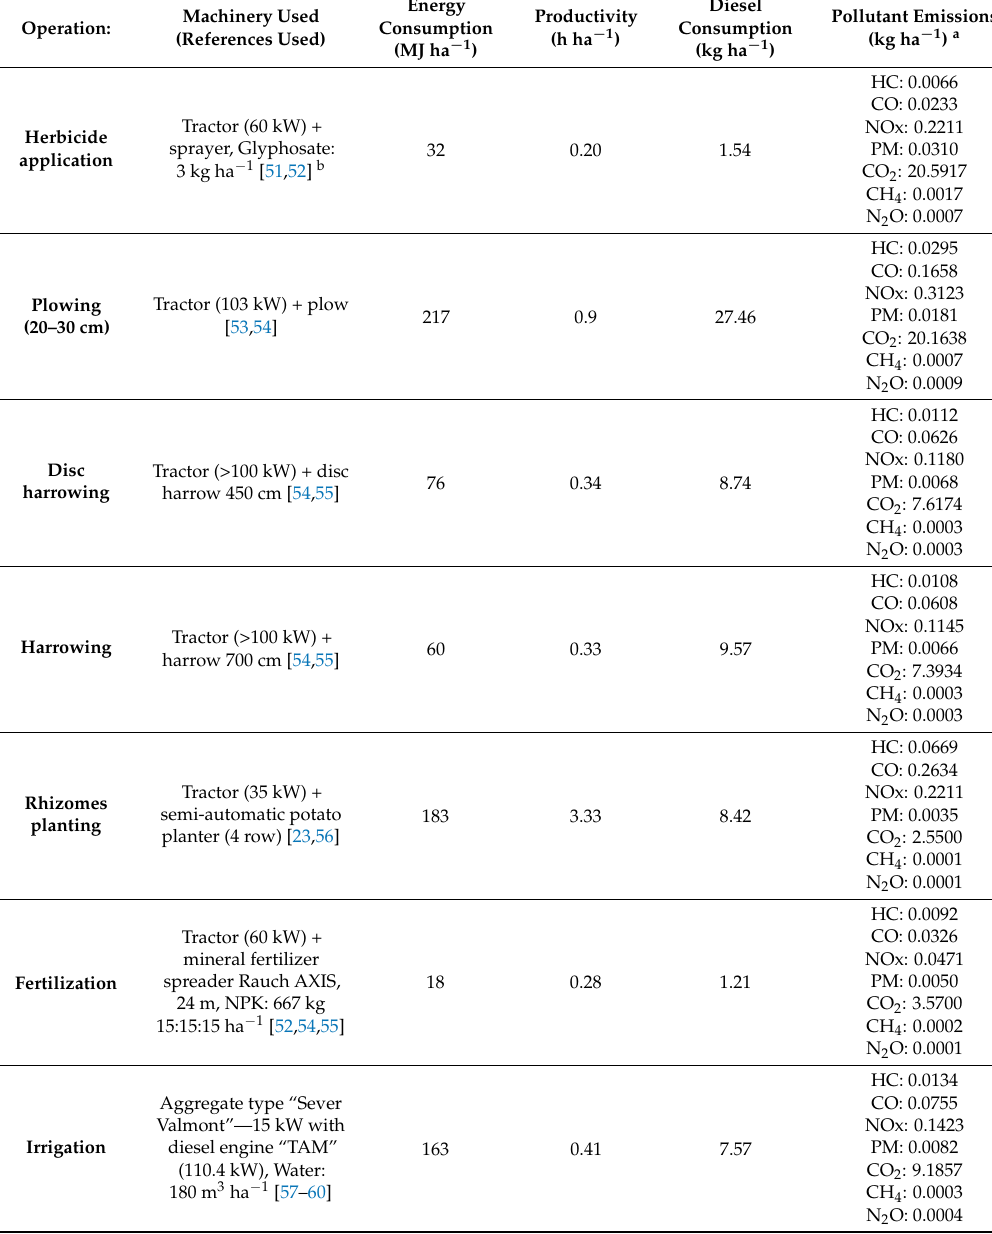
Table 1. Miscanthus ( Miscanthus × giganteus Greef et Deu.) life cycle operations, machinery selection, productivity and fuel consumption, calculated based on the functional unit (1 ha) and the reference flow (23.5 t, 85% dry matter (d.m.)